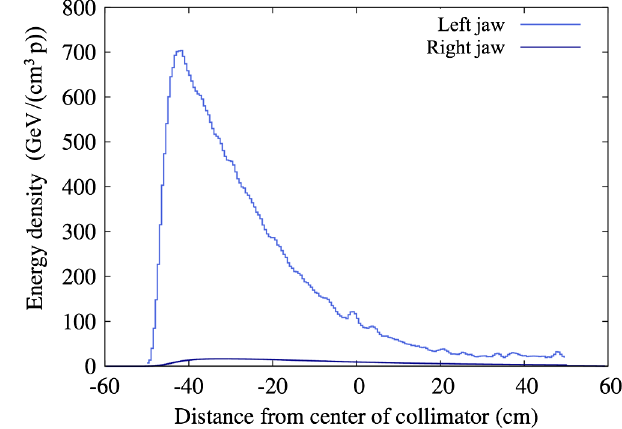
FIG. 18. Peak deposited energy profile along the TCTH.4R5.B2 jaws for Case 3.